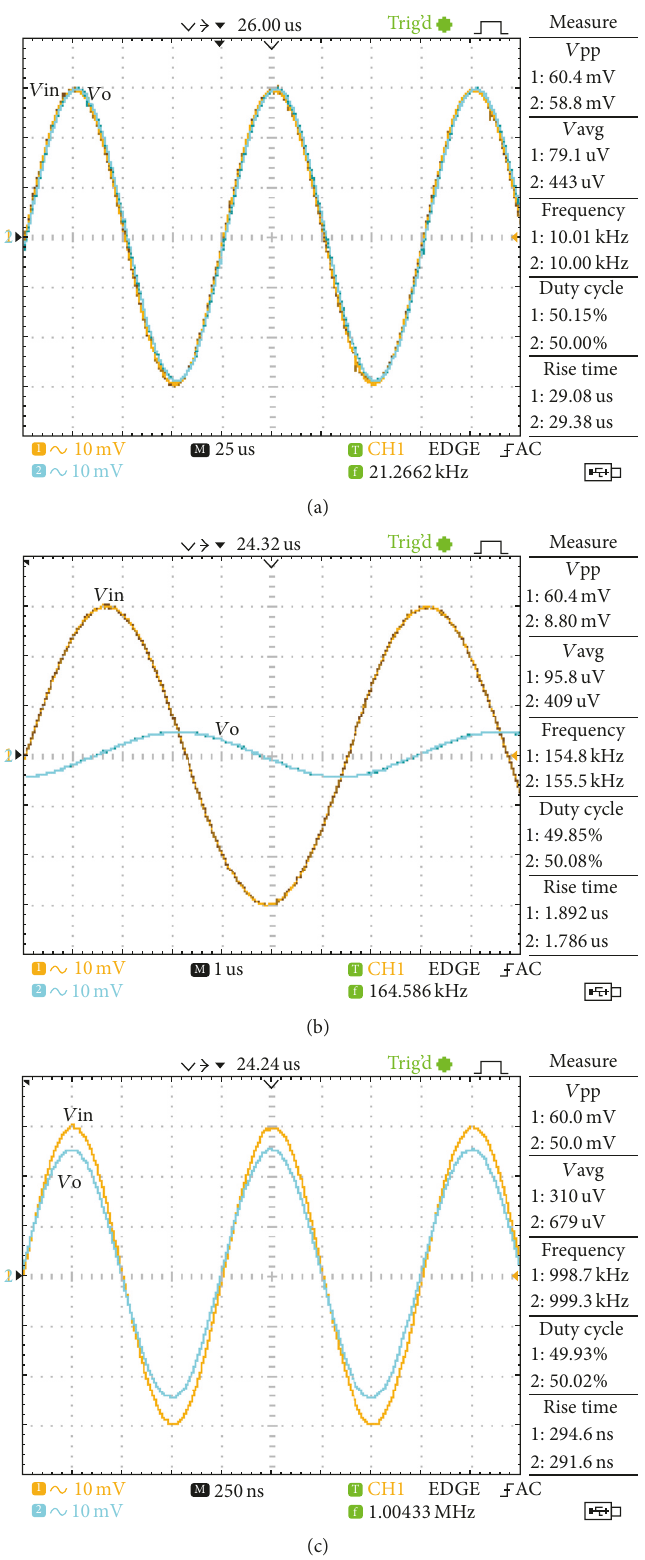
Figure 8: The measured input and output waveforms of band-reject filter at (a) 10kHz, (b) 155 kHz, and (c)